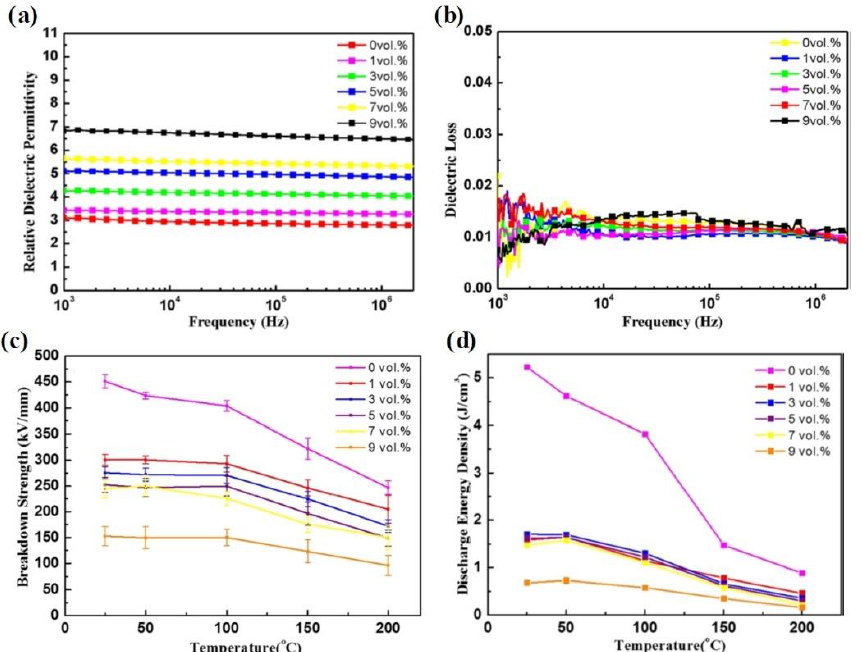
Figure 7. The relative dielectric permittivity ( a ) and dielectric loss ( b ) of BTO/PI nanocomposites with a BTO content of 0, 1, 3, 5, 7, and 9 vol % at ambient temperature. Dependences of breakdown strength ( c ) and discharge energy density ( d ) for pure PI and BTO/PI nanocomposites with BTO content of 1, 3, 5, 7, and 9 vol % on temperature ranging from 25 °C to 200 °C at 100 Hz. Reproduced with permission from Ref. [71]. Copyright 2017, American Institute of Physics.